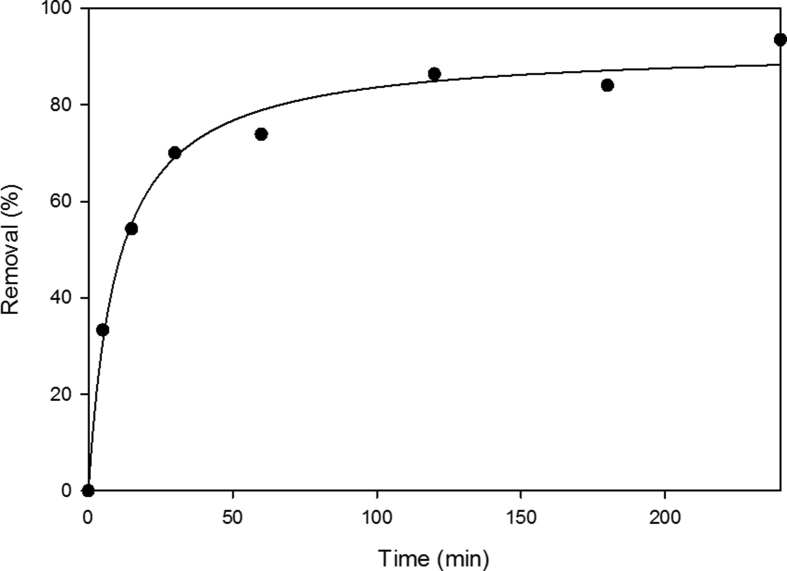
Effect of contact time on difenoconazole adsorption (in %) using hemp (conditions: volume 50 mL; solution at 12 mg/L; hemp dose = 0.35 g; agitation speed = 250 rpm; temperature = 25 °C; n = 3). In these batch experiments, the amount of difenoconazole adsorbed was expressed in percentage removal.